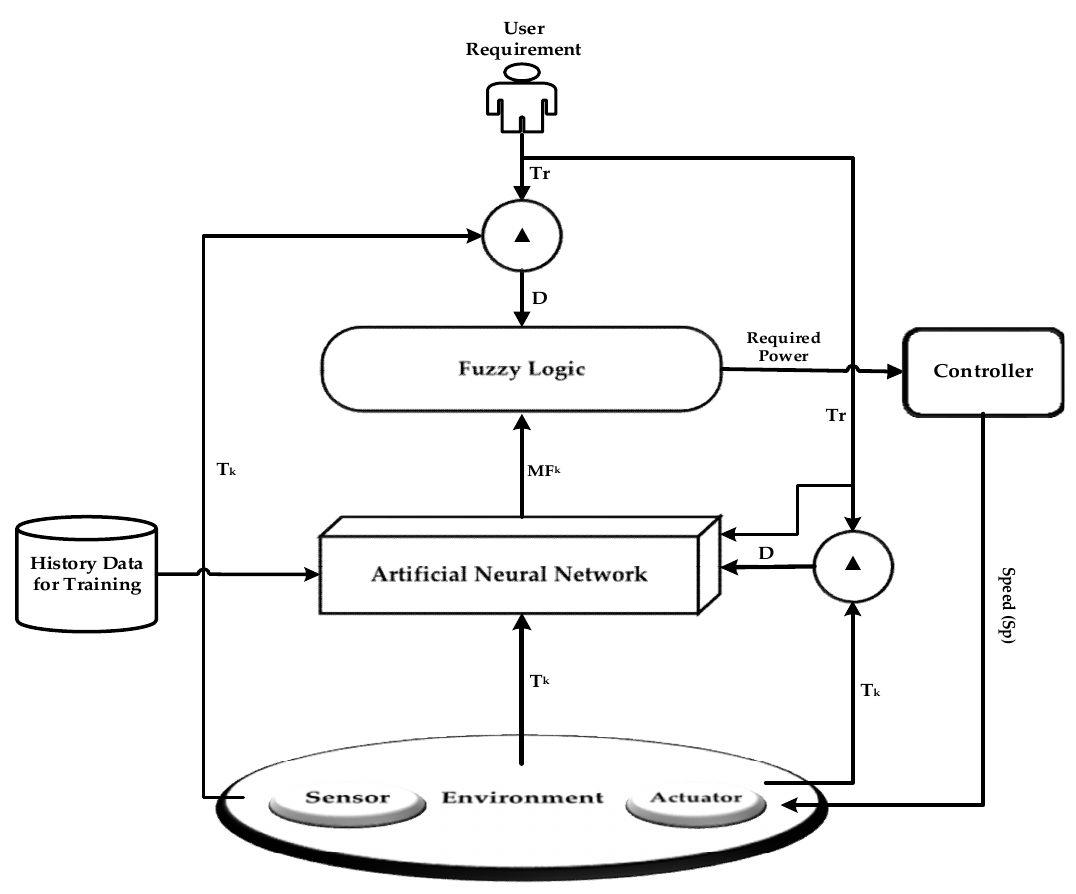
Figure 2. Learning to fuzzy logic control model for temperature control in an indoor environment.